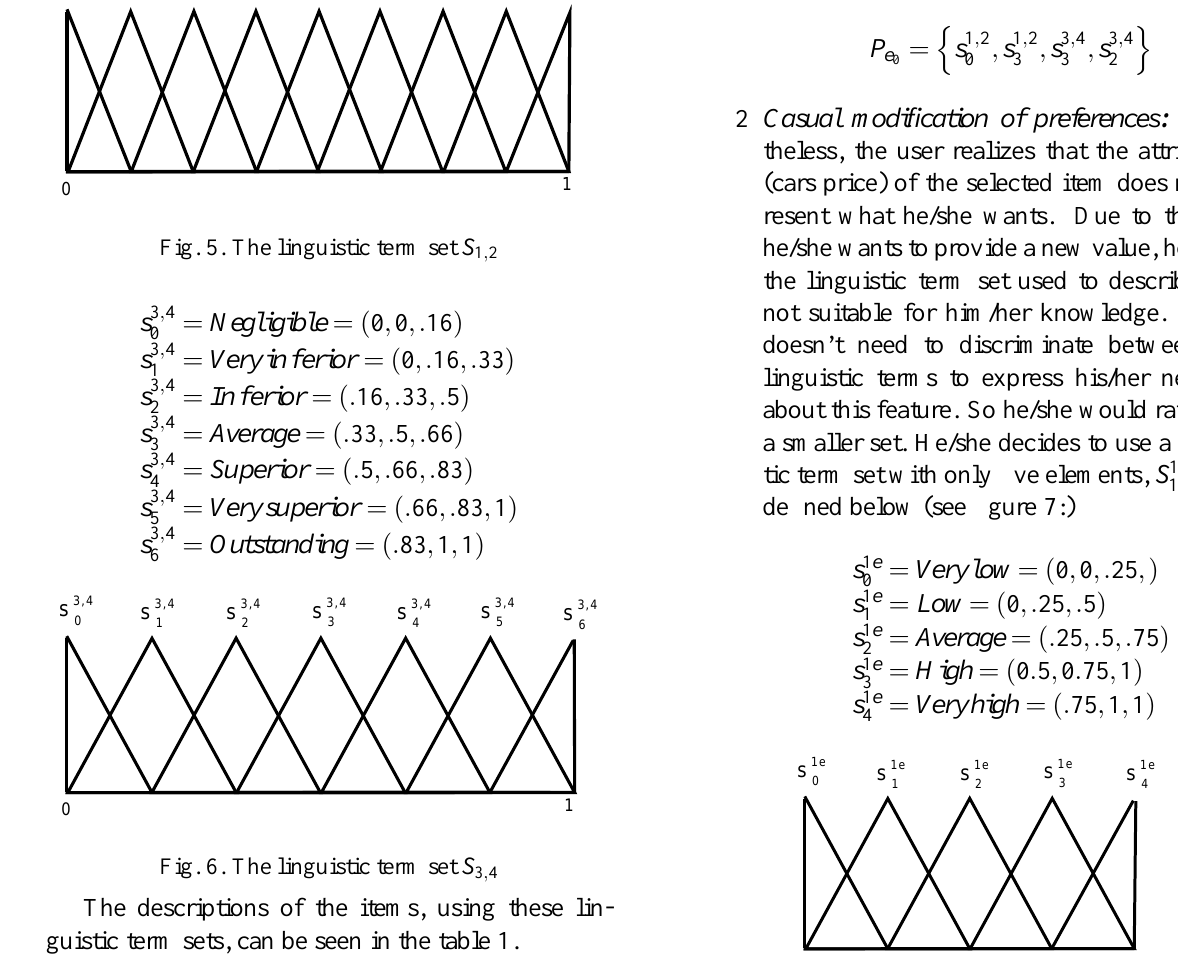
Fig. 6. The linguistic term set S 3 , 4